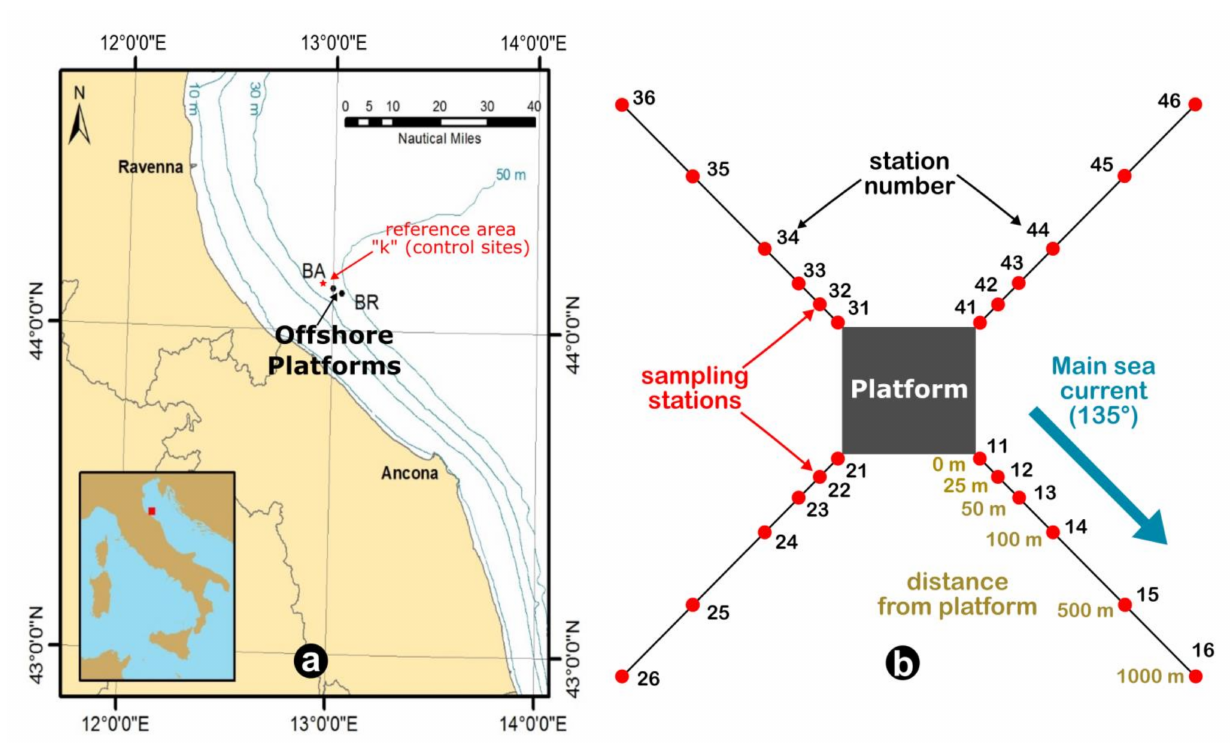
Figure 1. A map showing the location of the offshore platforms in Adriatic Sea ( a ) and sampling strategy for each platform named BA and BR ( b ).